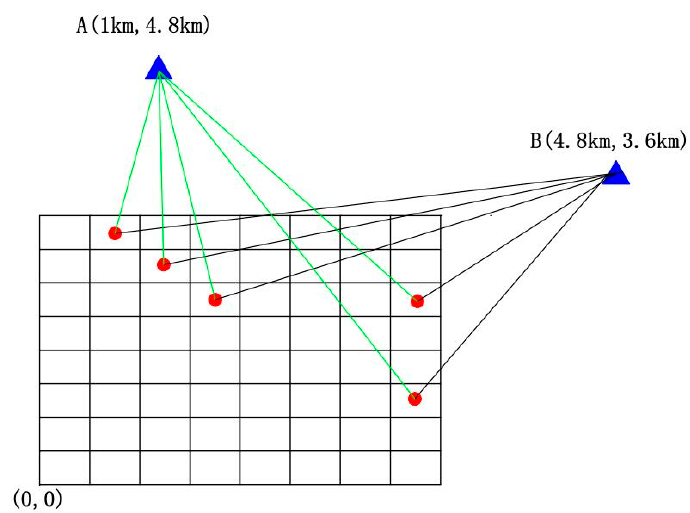
Figure 3. Schematic diagram of wind turbine noise source propagations towards receiver.